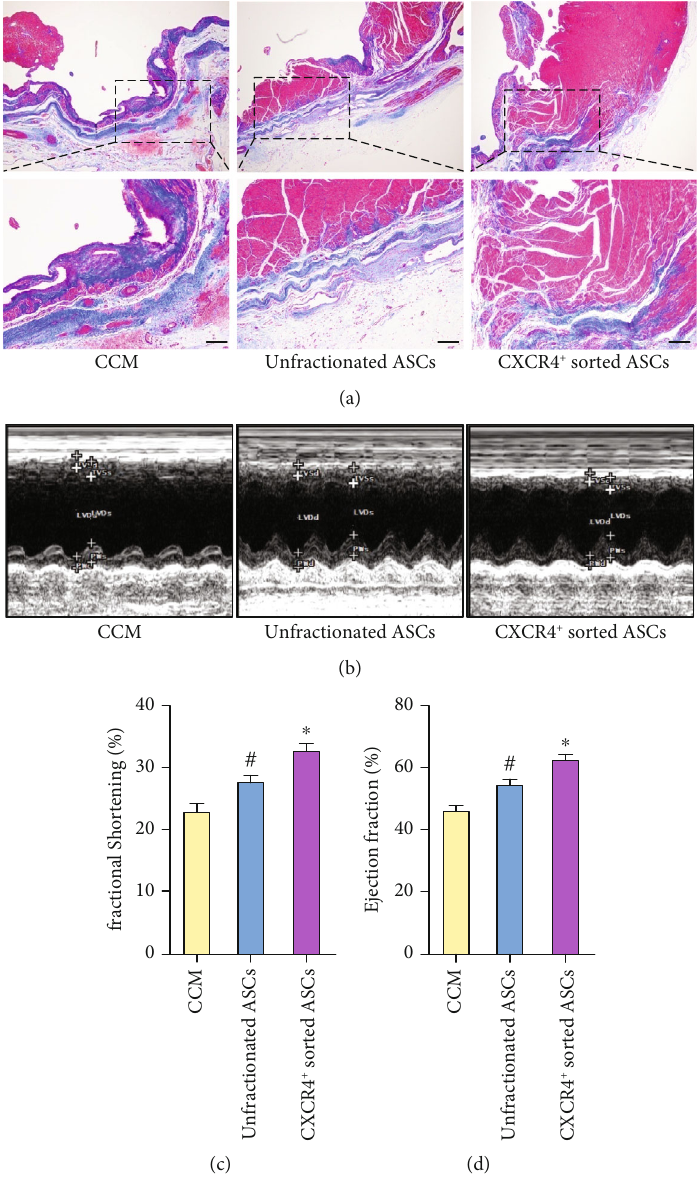
Figure 7: CXCR4 + sorted ASCs more potently improved cardiac contractility and inhibited scar formation than did unfractionated ASCs in vivo. (a) Representative Masson ’ s trichrome staining was depicted (blue, fi brous tissue and red, viable myocardium). More viable myocardium and less fi brous tissue were observed in CXCR4 + sorted ASC-treated rats than in unfractionated ASC-treated rats and in CCM control rats. (b) Representative M-mode echocardiographic data in infarcted hearts receiving CCM, unfractionated ASCs, and CXCR4 + sorted ASCs at 4 weeks posttransplantation. (c) Comparison of ejection fraction and fractional shortening as assessed by echocardiography. CXCR4 + sorted ASC-treated rats demonstrated a statistically signi fi cant improvement in ejection fraction and fractional shortening at 4 weeks posttransplantation as compared with CCM or unfractionated ASC-treated rats. Scale bar represents 50 μ m. # p < : 05 versus CCM. ∗ p < : 05 versus unfractionated ASCs. Abbreviations: CXCR4: CXC-chemokine receptor 4; ASCs: adipose- derived stem cells; CCM: cell culture